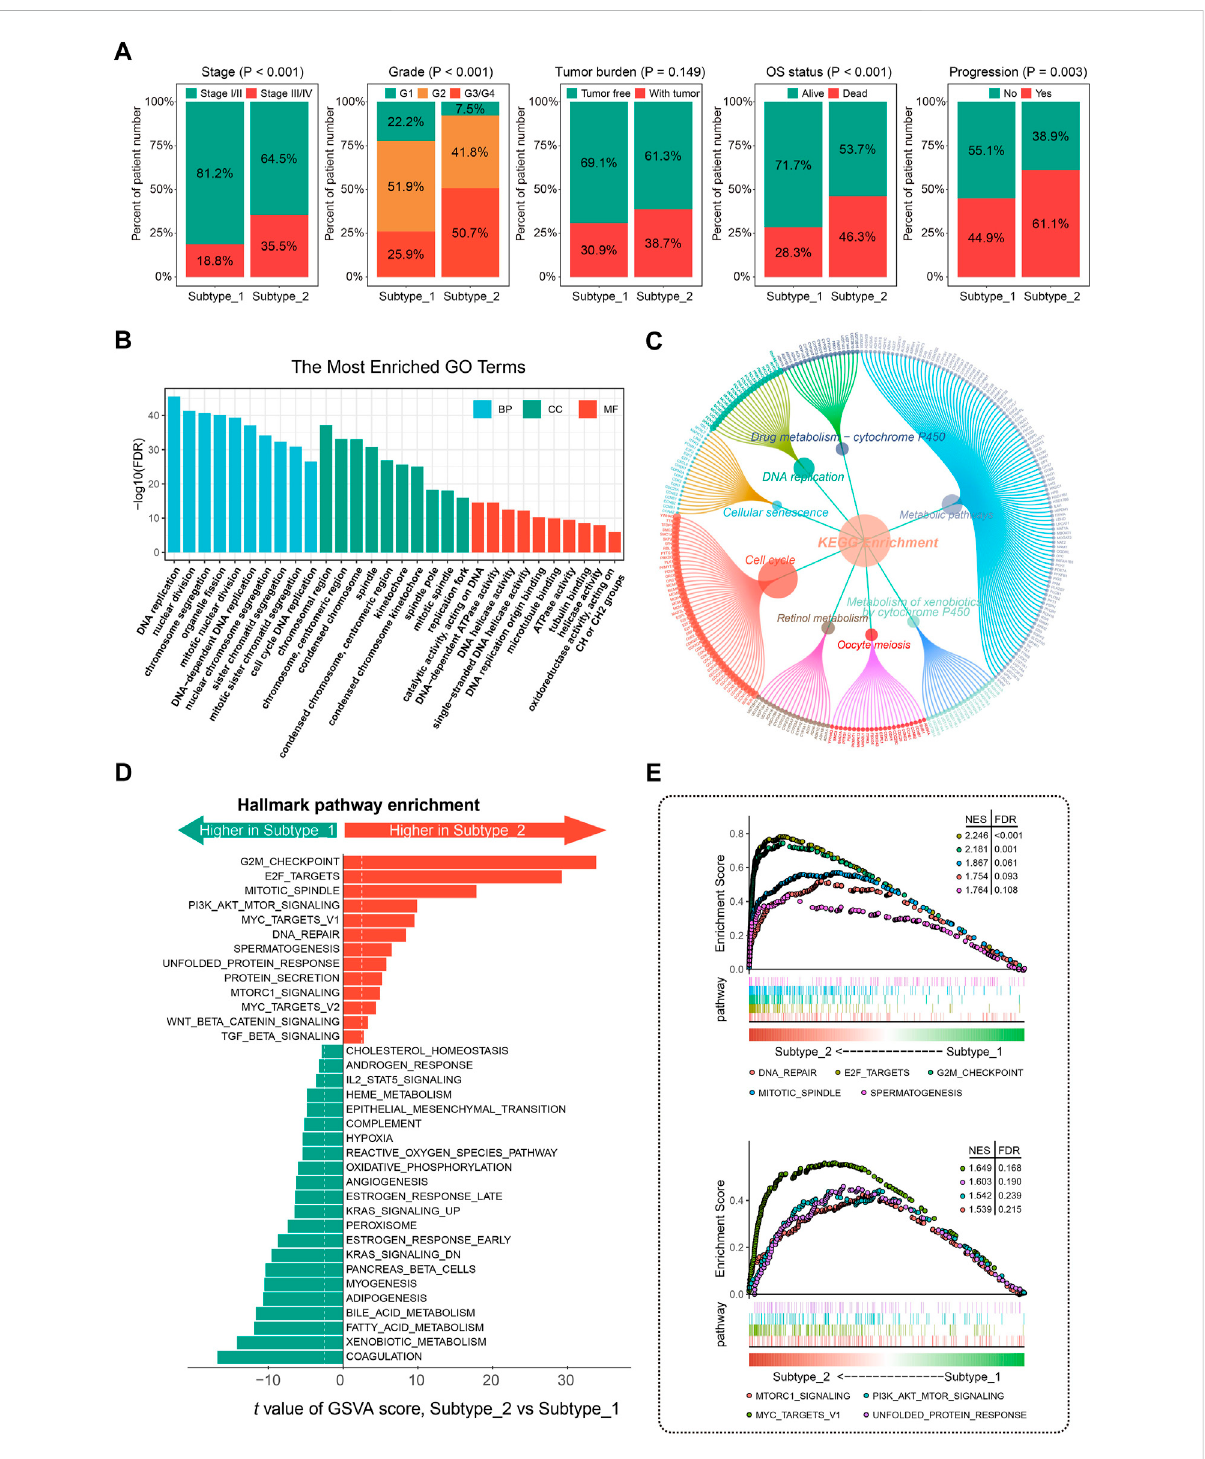
FIGURE 3 Clinical signi fi cance and molecular characteristics of CSG patterns of HCC. (A) Proportions of subgroups divided by tumor stage, grade, tumor burden, OS status, and progression status in different CSG subtypes. (B,C) GO (B) and KEGG (C) enrichment analysis of the DEGs between CSG subtypes. (D,E) Signi fi cant hallmark pathways enriched by GSVA (D) and GSEA (E) between CSG subtypes. GO, gene ontology; KEGG, Kyoto Encyclopedia of Genes and Genomes; GSVA, gene set variation analysis; GSEA, gene set enrichment